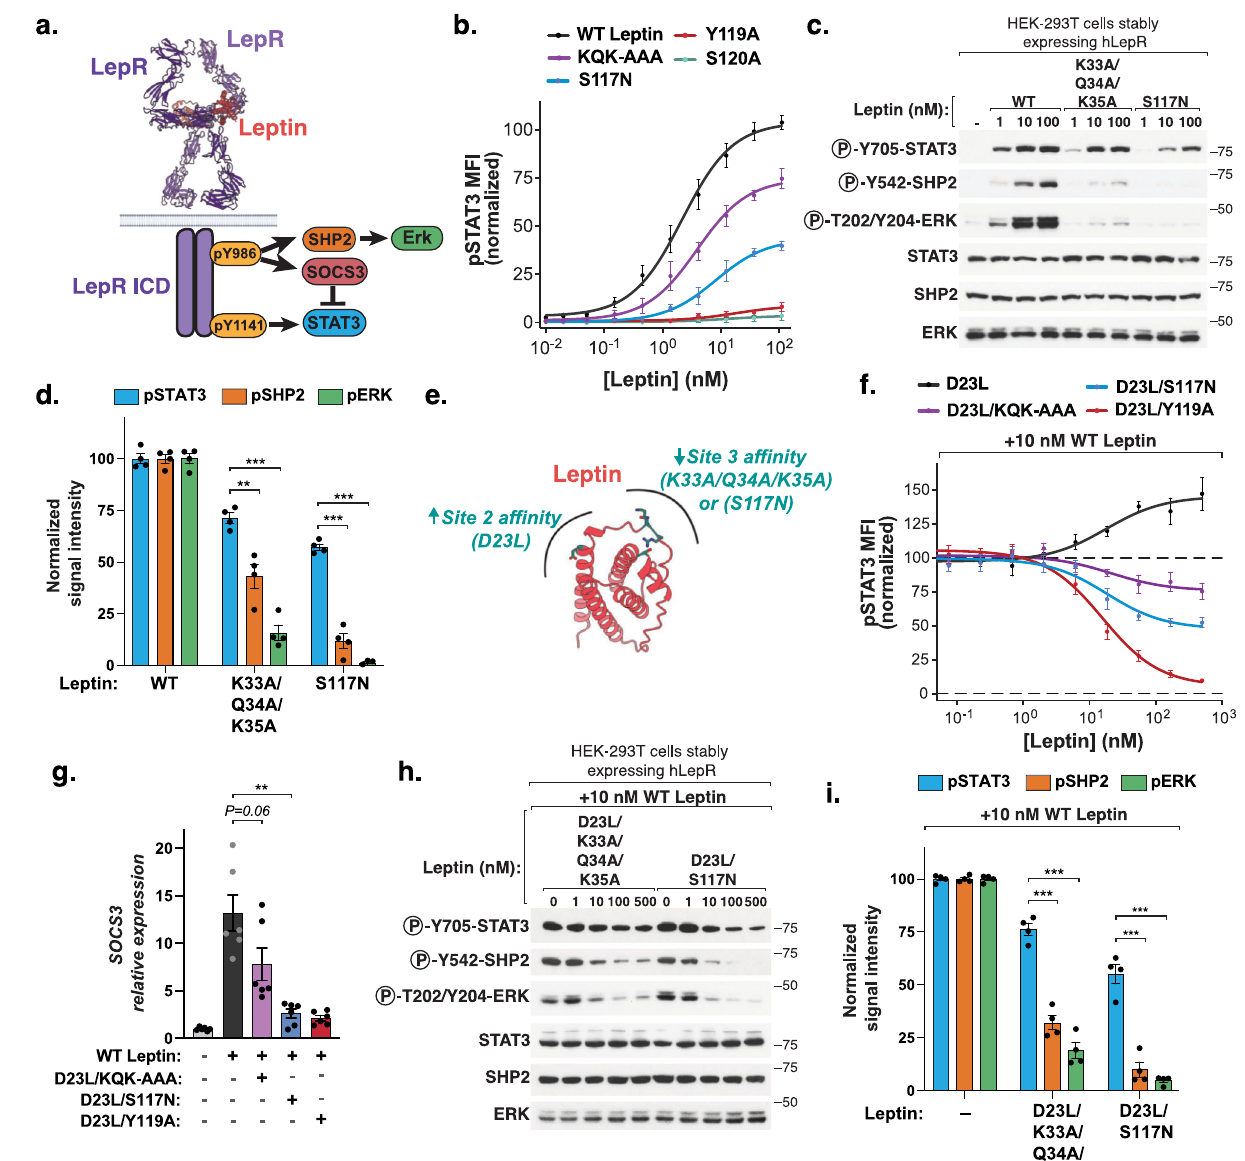
Fig.4|BiasedleptinanalogsdecoupleactivationofSTAT3fromLepRnegative regulators. a Cartoon model of LepR signaling in which STAT3 recruited by phosphorylation ofLepR-Y1141, whereasLepR negative regulatorsare recruited by phosphorylation ofLepR-Y986. b Phospho-STAT3 dose-response curves for WT or mutant leptin in LepR-expressing HEK 293T cells, analyzed by fl ow cytometry and shown as a percent of maximal WT leptin mean fl uorescent intensity (MFI±SEM, n =4 (mutants) or 6 (WT) independent replicates). c Immunoblot of lysates pre- pared from HEK-293T cells stably expressing wild-type LepR that were